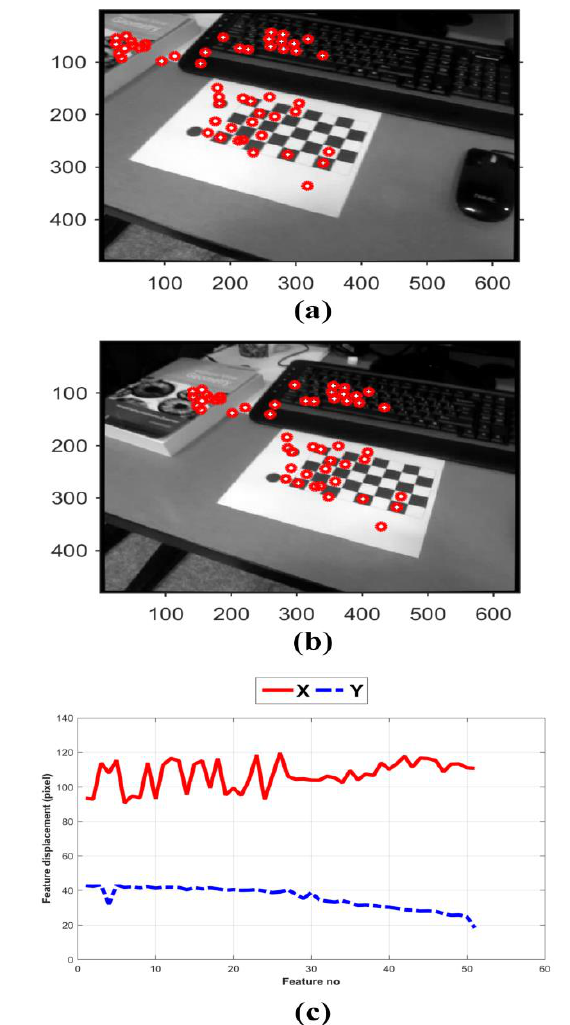
Figure 3. Wide-baseline condition (a) and (b) sparse set of feature correspondences (c) displacement of corresponding features in X and Y